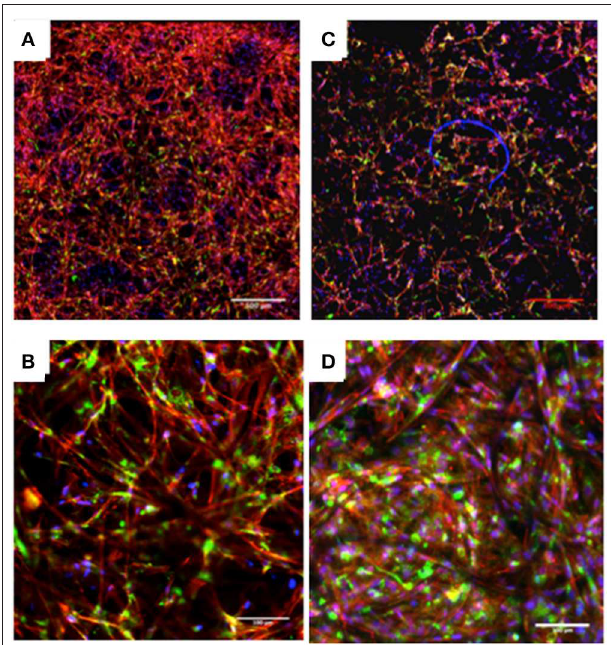
FIGURE 7 | Confocal images of hDF cultured in PCL (A,B) and PCL/Alginate (C,D) electrospun scaffolds after 14 days in culture showing collagen type I staining (Blue—DAPI, Red—Phalloidin, Green—Collagen I). Collagen type I is found in both conditions. Scale bar: (A,C) 500 µ m; (B,D) 100 µ